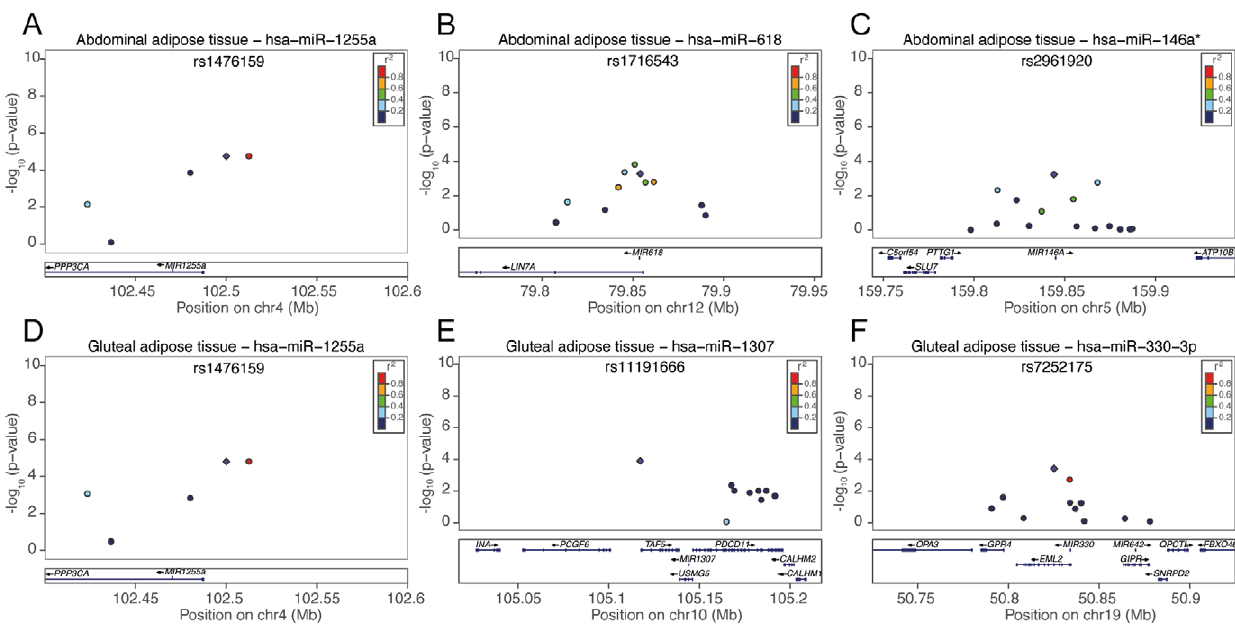
Figure 2. Locus plots for miRNA eQTLs that replicated. P-values from the primary study are shown in figure (criteria for replication: p- value , 0.001 in the primary study and p-value , 0.05 in the replication study with a directionally consistent effect). A) Abdominal adipose tissue hsa- miR-1255a :rs1822168 (p-value=1.83E-05 in primary study and p-value=9.91E-03 in replication study) B) Abdominal adipose tissue hsa-miR-618 : rs1716543 (p-value=5.34E-04 in primary study and p-value=5.80E-03 in replication study) C) Abdominal adipose tissue hsa-miR-146a* :rs2961920 (p-value=5.87E-04e in primary study and p-value=6.45E-06 in replication study) D) Gluteal adipose tissue hsa-miR-1255a :rs1822168 (p-value=1.56E- 05 in primary study and p-value=1.65E-04 in replication study), E) Gluteal adipose tissue hsa-miR-1307 :rs11191666 (p-value=1.27E-04 in primary study and p-value=3.55E-04 in replication study), F) Gluteal adipose tissue hsa-miR-330-3p :rs7252175 (p-value=3.85E-04 in primary study and p- value=4.04E-02 in replication study).